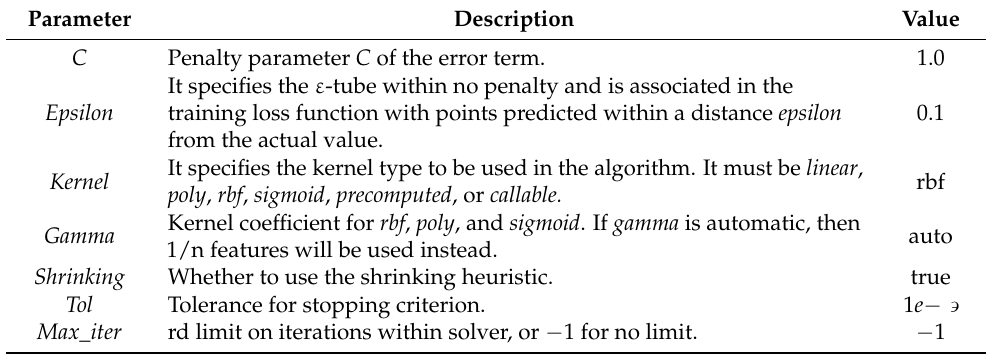
Table 4. Defined parameters in the SVR library in order to characterize the prediction